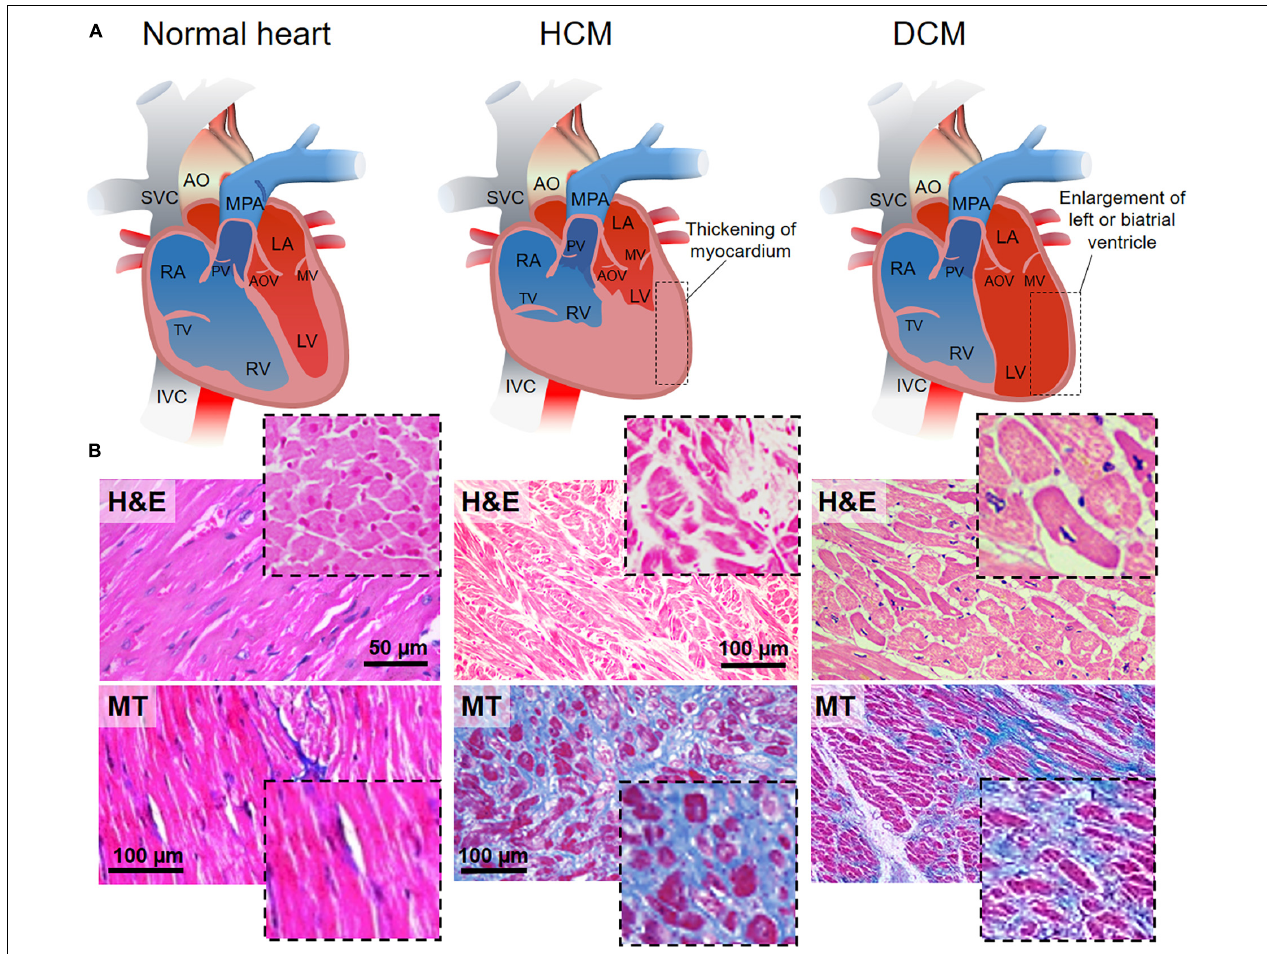
FIGURE 1 | HCM and DCM as the most common cardiomyopathies. (A) Schematic representations of the anatomy of normal (left), hypertrophic (hypertrophic cardiomyopathy, HCM, middle) and dilated (dilated cardiomyopathy, DCM, right) heart. HCM is characterized by left ventricle thickening, while DCM is defined by the dilation of the left ventricle. AO, aorta; SVC, superior vena cava; MPA, main pulmonary artery; RA, right atrium; RV, right ventricle; TV, tricuspid valve; PV, pulmonary valve; LA, left atrium; LV, left ventricle; MV, mitral valve; AOV, aortic valve; IVC, inferior vena cava. (B) Hematoxylin-eosin (H&E, top) staining in longitudinal and transversal (inset) sections of the cardiac muscle. Normal heart shows the organized and parallel alignment of cardiomyocytes (dashed black line) with preserved cell body and sarcomeric structures. Disorganized cellular structures are highlighted in HCM and DCM sections. Nuclei appear in violet, cytoplasm in pink. Masson’s trichrome (MT, bottom) staining in longitudinal and transversal (inset) sections of cardiac muscle. The homogeneity, the continuity and organization of the healthy tissue (pink) is perturbed by the accumulation of fibrotic non-contractile tissue (blue) in HCM and DCM hearts. Missing scale bars were not provided in the